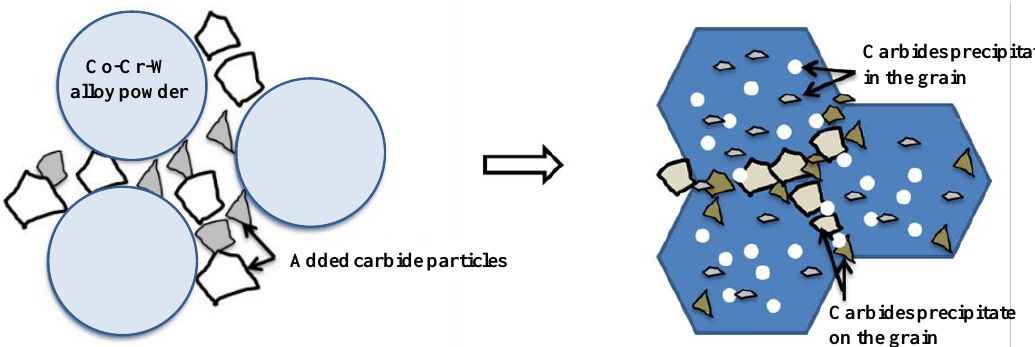
Figure 1. Schematic of the microstructure of the alloy prepared by introducing the reinforced carbides [14].